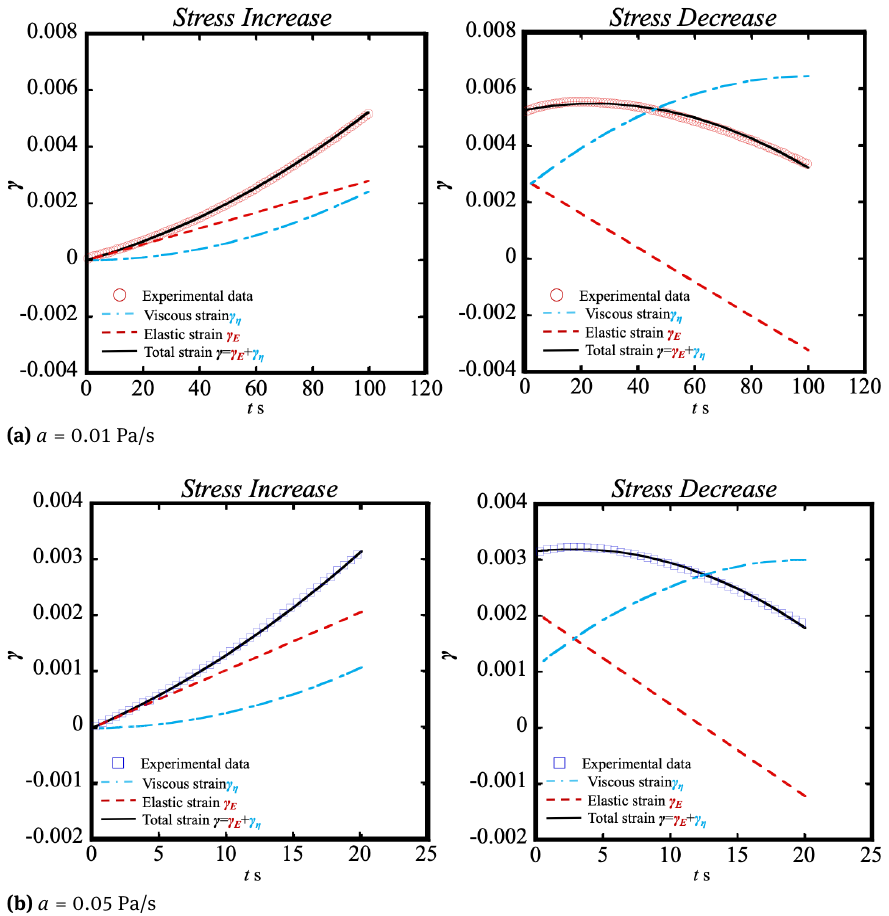
Figure 7: Comparison of the elastic and viscous strains obtained from experiments and Maxwell model fitting of the α -gel O/W emulsion. Stress-ramp rates: (a) a = 0.01 Pa/s, (b) a = 0.05 Pa/s, (c) a = 0.1 Pa/s, and (d) a = 0.5 Pa/s. The viscoelastic characteristics in the